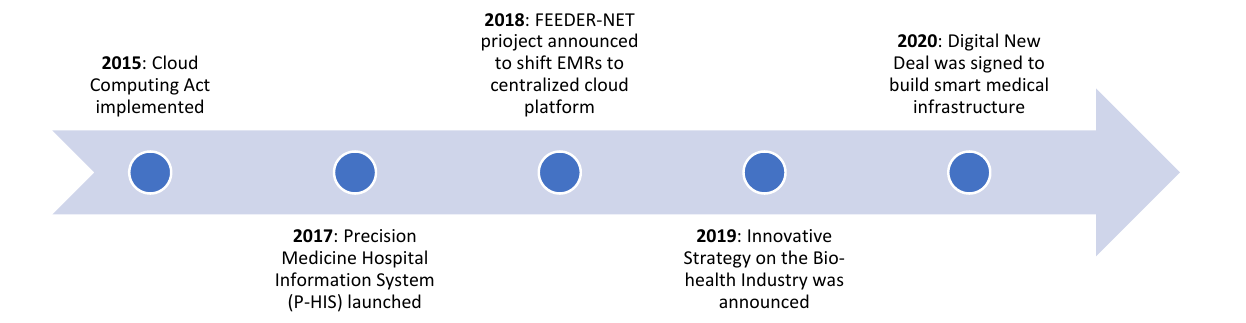
Figure 2. Policy trajectory from cloud adoption to public health innovation in South Korea.